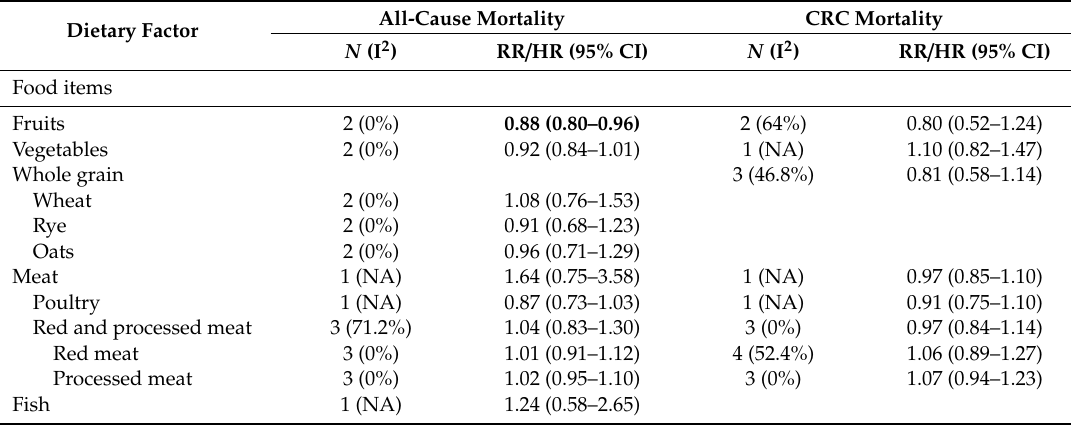
Table 2. Systematic review and meta-analysis of the associations between prediagnostic dietary intake and mortality among colorectal cancer survivors.